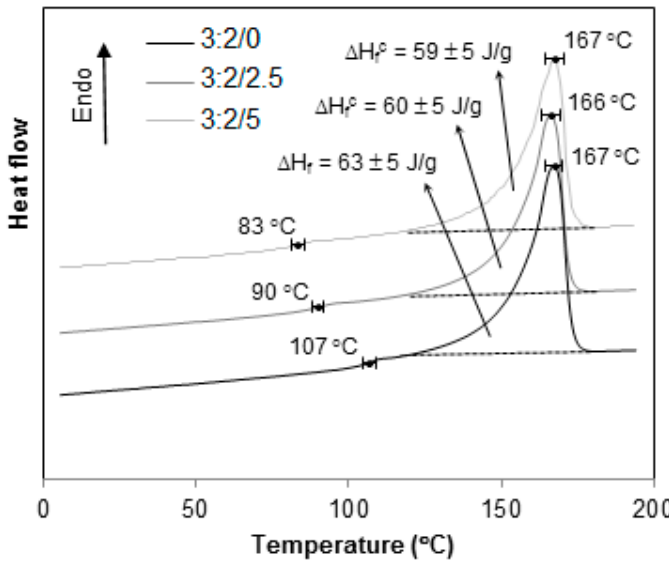
Figure 12. DSC thermograms for 3:2 PP / HIPS blends with 0, 2.5 and 5 phr of CNSL.